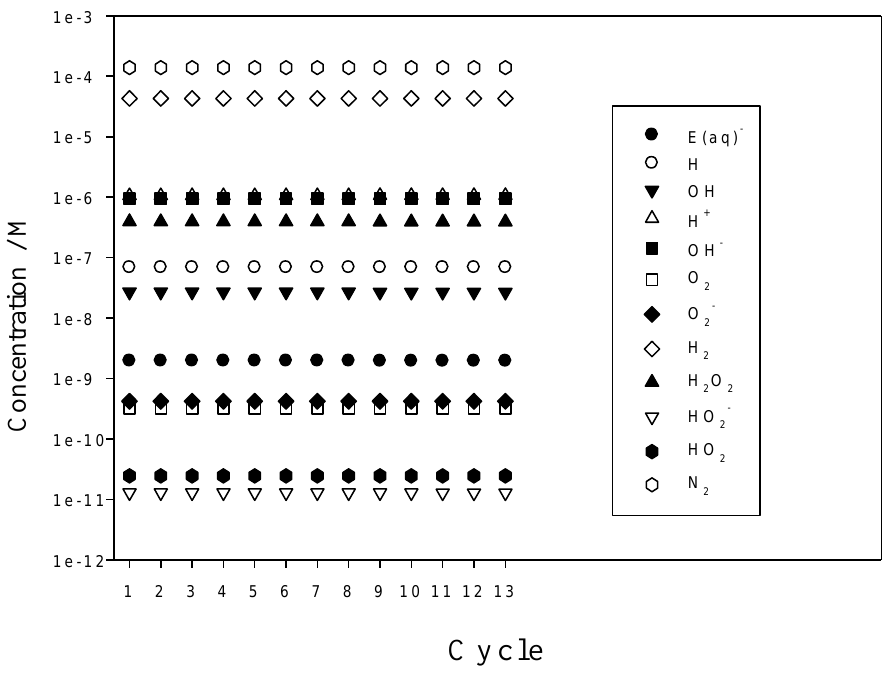
Figure 37. Calculated average concentrations of radiolysis species at the Plasma Flux Area outlet as a function of the number of revolution cycles. [H 2 ] Inlet = 1 cc (STP)/kg H 2 O.